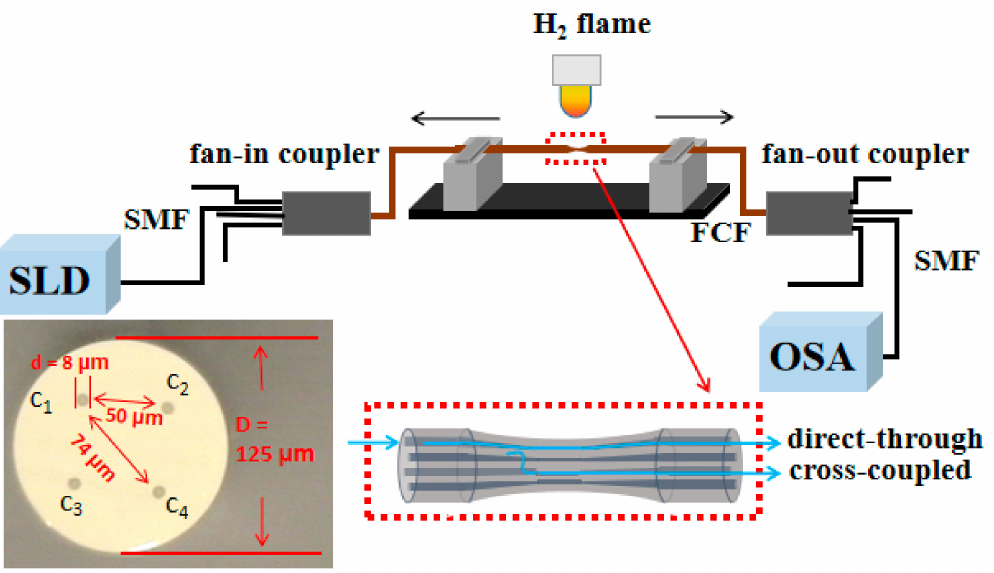
Figure 1. Experimental set-up of the tapered FCF interferometer in which c 1 , c 2 , c 3 , c 4 represent the excitation core, two neighboring cores, and diagonal cores, respectively. The inset picture shows the designation of the four cores of the un-tapered FCF under 1000 × CCD